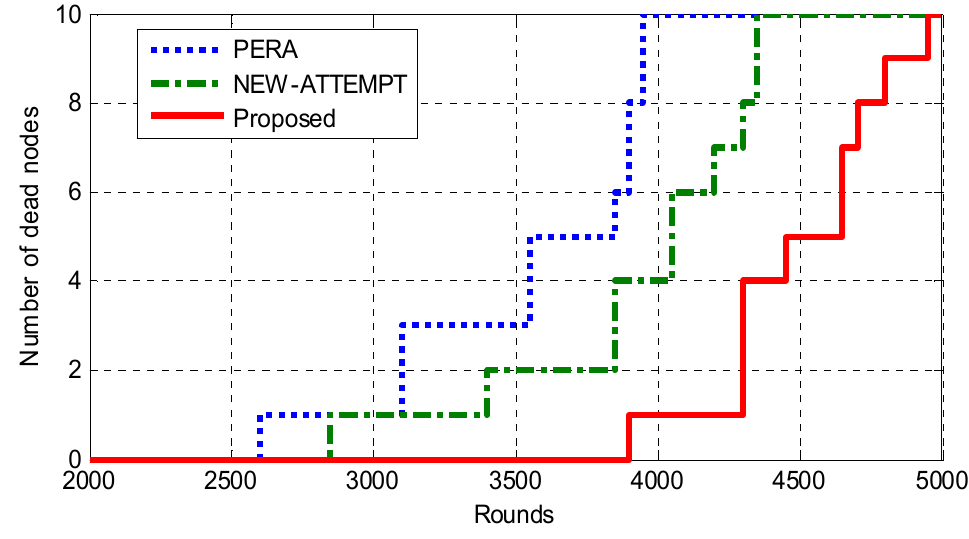
Figure 4. Analysis of network lifetime.